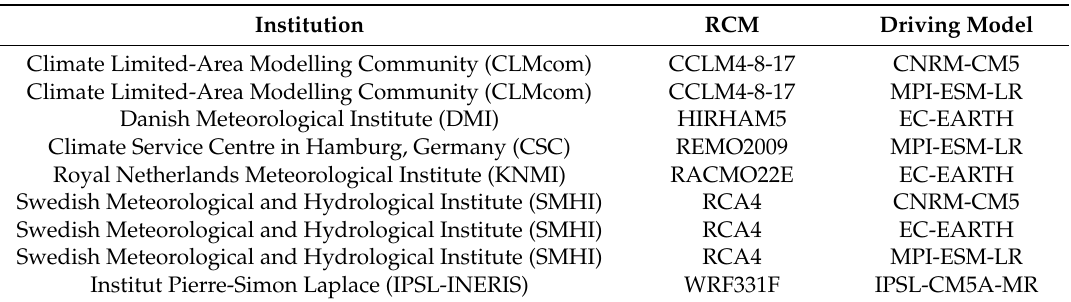
Table 2. Overview of the Regional Climate Models (RCMs)